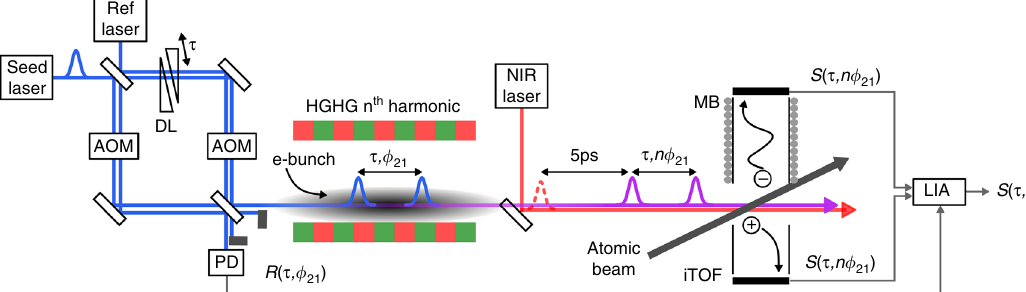
Fig. 1 Experimental scheme. Intense twin-seed pulses are generated in an ultra-stable monolithic interferometer. The pulse delay τ is set by a wedge-based delay line (DL), and phase-locked acousto-optic modulators (AOMs) control the relative phase ϕ 21 of the seed pulses. The time- and phase-controlled pulse pairs seed the high-gain harmonic generation (HGHG) process in the FEL, resulting in coherent XUV pulse pairs with precisely controlled timing and relative phase. The XUV pulse pair tracks the real-time evolution of electronic coherences induced in an atomic beam sample. Detection is done via photoionization with a third pulse from a near infrared (NIR) laser. Both photoelectrons and -ions are detected with a combined magnetic bottle electron (MB) and ion time-of- fl ight (iTOF) spectrometer. A continuous-wave reference laser is used to trace the phase evolution and jitter in the interferometer, recorded with a photodiode (PD). This signal is used for rotating frame sampling and phase-sensitive detection of the mass/energy-gated ion/electron yields with a lock-in ampli fi er